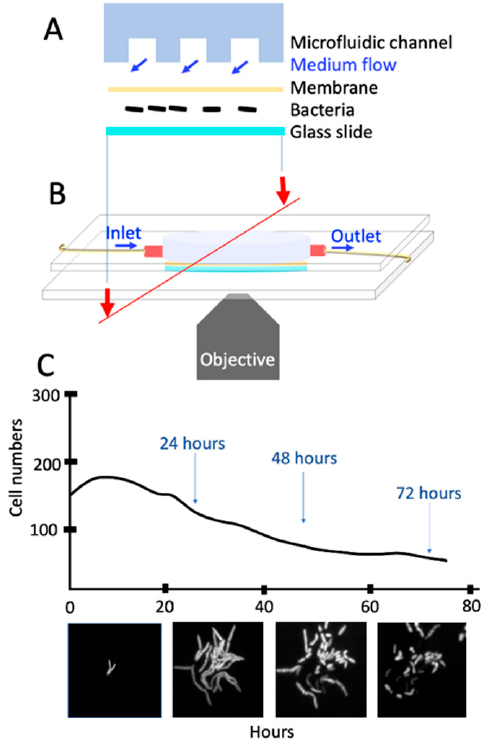
Figure 5. A single-cell assay using microfluidics and microscopy. ( A ) Cross-section of the microfluidic device with its components. ( B ) Microfluidic device on the microscope stage for live-cell fluorescence imaging. ( C ) View of the bacteria in the microfluidic device and phases of antibiotic exposure. In this system, the polydimethylsiloxane (PDMS) microfluidic device allowed